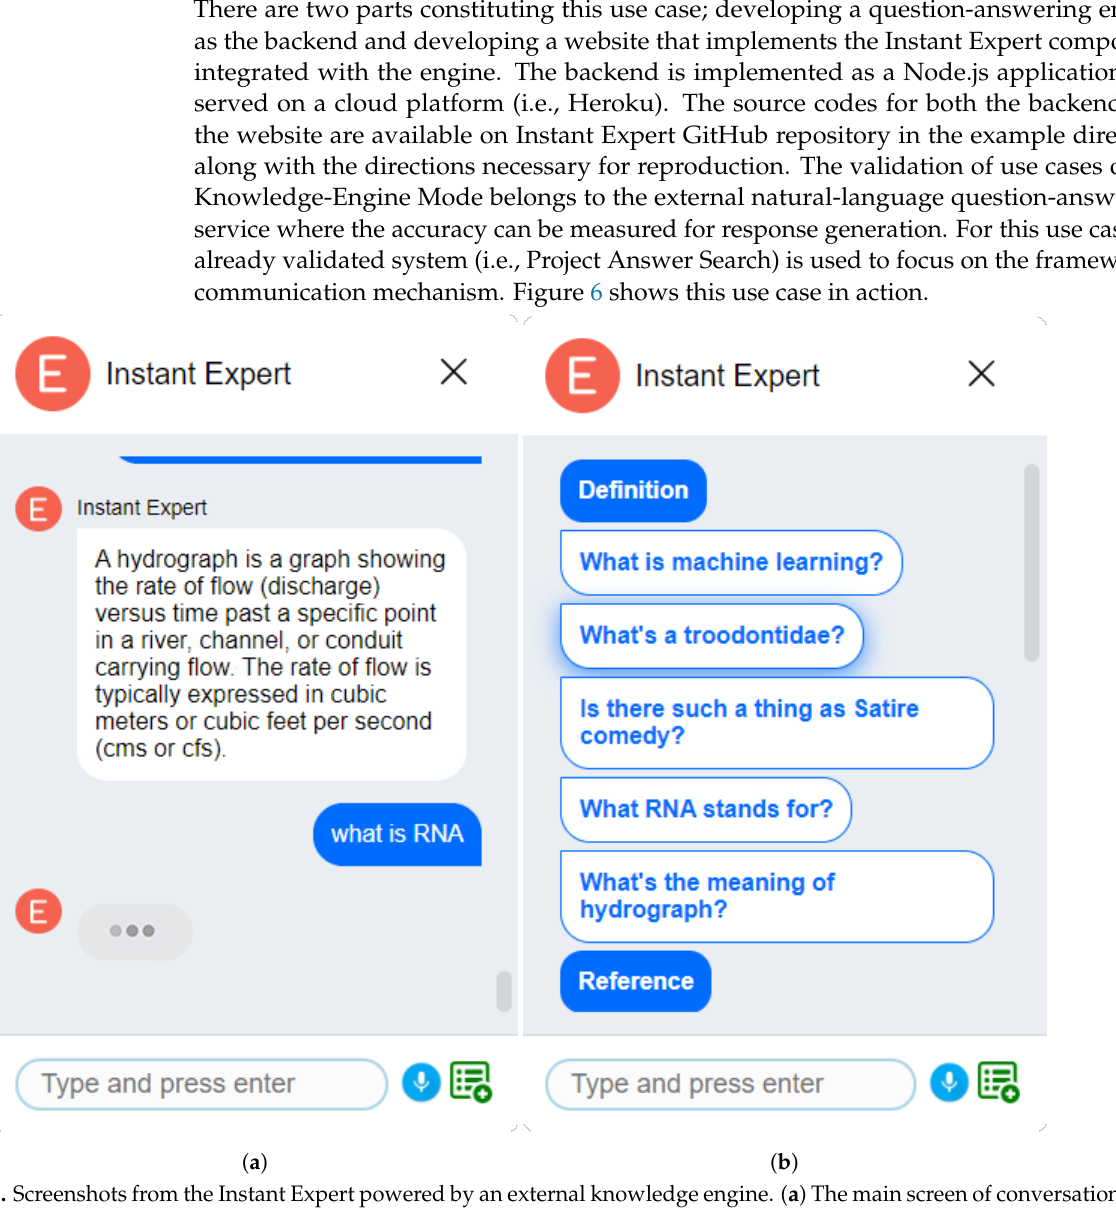
with buttons to activate voice input and display example questions, ( b ) example questions that can be asked to the chatbot